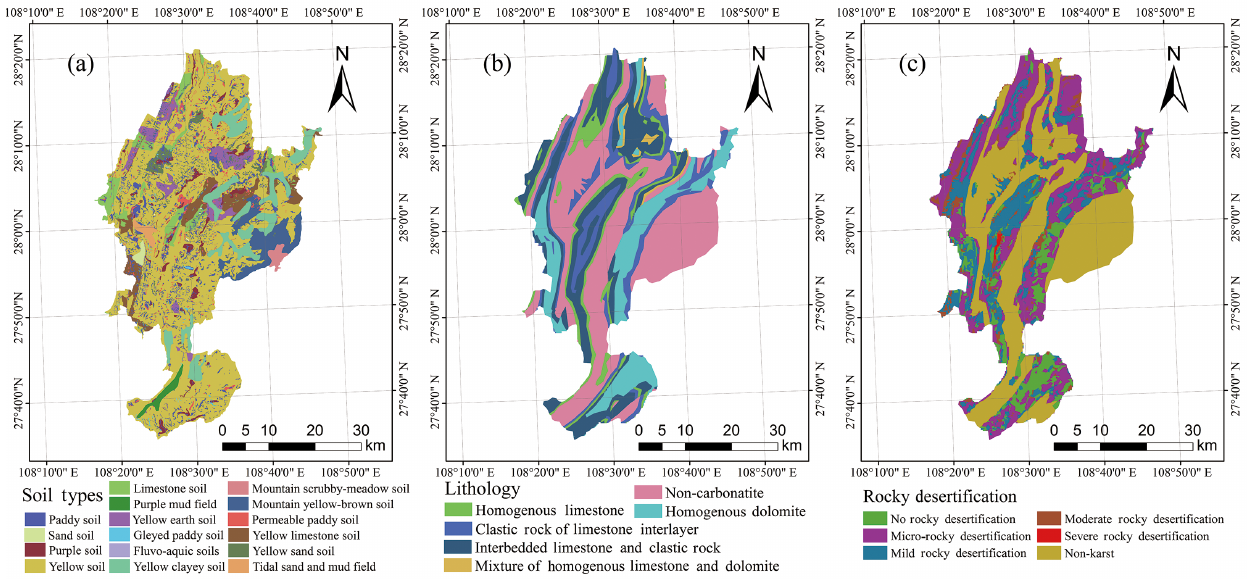
Figure 2. Study area geological background: soil map (a) , lithology (b) , and rocky desertification (c) .